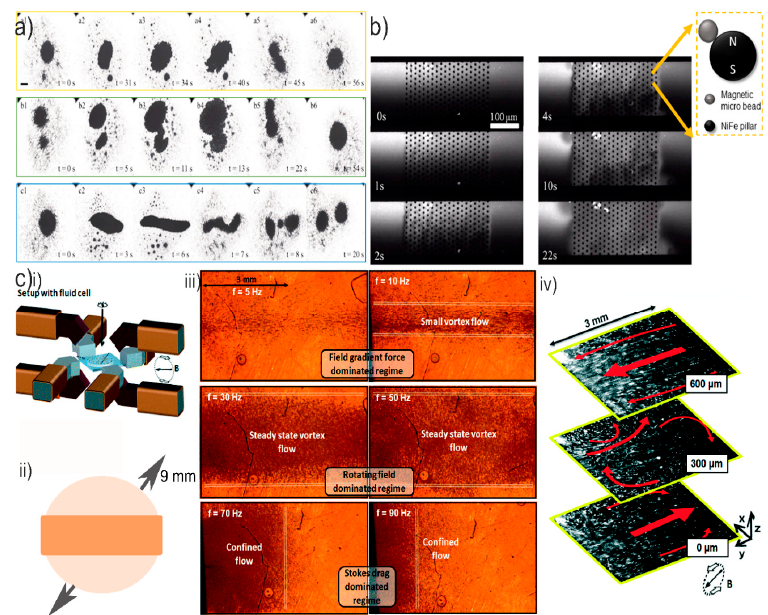
Figure 7. ( a ) Experimental results at a 7.5 mT rotating magnetic field. ( a1 – a6 ) Reversible spread state (yellow square), ( b1 – b6 ) merging of two swarm vortexes (green square), and ( c1 – c6 ) splitting of a swarm vortex to two smaller swarms (blue square). Scale bar 600 µ m. Image reproduced with permission from [120], published by SAGE, 2018. ( b ) The NiFe array of [122]. Magnetic beads were attracted to each NiFe pillar and once the magnetic field becomes rotational, the magnetic beads started rotating by locally stirring the fluid. Since the microchannel floor consisted of a planar array of several NiFe features, the collective rotation of all pillars resulted in global mixing. Images reproduced with permission from [122], published by Elsevier, 2016. ( c ) Global collective motion behavior of micro stirrers [123]: ( i ) The experimental setup of the chamber in the middle of an octopolar electromagnetic system, ( ii ) top view sketch of the microfluidic chamber with an indication of where the vortex occured, and ( iii ) the di ff erent regimes of swarming particles. A clockwise rotating vertical magnetic field (30 mT) was applied and the final shape of swarming particles was observed at di ff erent rotational frequencies of the applied field. A steady state vortex flow stretched along the entire length of the microchamber, was found at 30 Hz and 50 Hz. ( iv ) Flow behavior. The global induced motion (red arrows) of the fluorescent tracer particles (white spots in three planes over the height of the cell. Near the bottom (z = 0 µ m) and upper (z = 600 µ m) surfaces of the fluid cell, the flow field was unidirectional. At the center of the cell (z = 300 µ m), small and local vortices appeared. Images reproduced with permission from [123], published by the Royal Society of Chemistry,